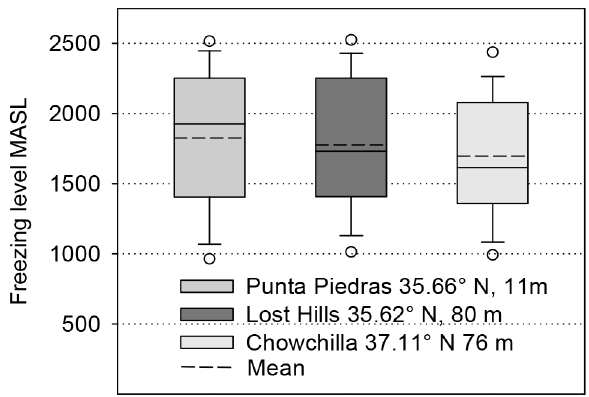
Figure 5. 3 December–23 March accumulation period hourly bright-band freezing level recorded at three wind-profiler stations upwind of the study area; locations shown in Fig. 1. Circles are 5th and 95th